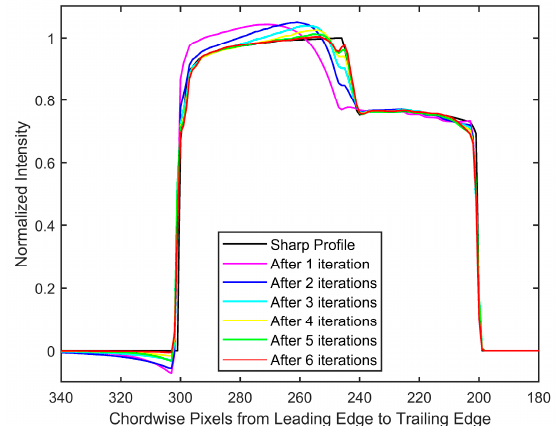
Figure 14. Restored intensity values after different iterations at r / R = 0.95. Rotation is toward increasing pixel values.